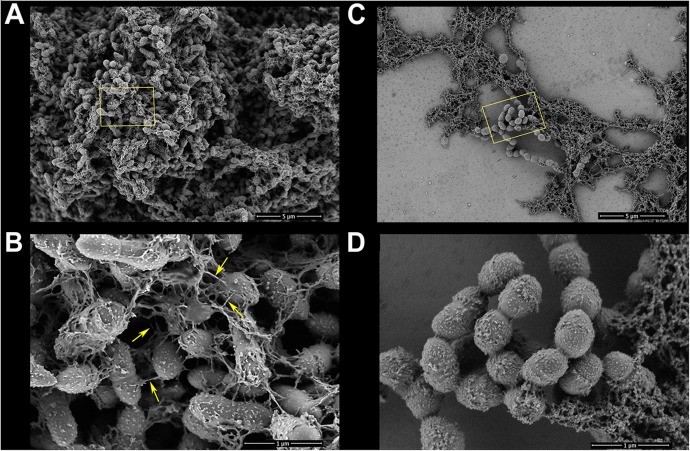
Biofilms of S. mutans UA159 in the control-ethanol (0.031%) group and TF3 (1/4×MIC) group were visualized by FE-SEM. Panels (A) and (B) show biofilms in the control group at magnifications of 5,000 and 30,000×, respectively. Bacterial cells in the control group exhibited substantial surrounding EPS matrixes (yellow arrows show nanofibers connecting bacterial cells). Panels (C) and (D) show biofilms grown with TF3 (1/4×MIC) at magnifications of 5,000 and 30,000×, respectively.